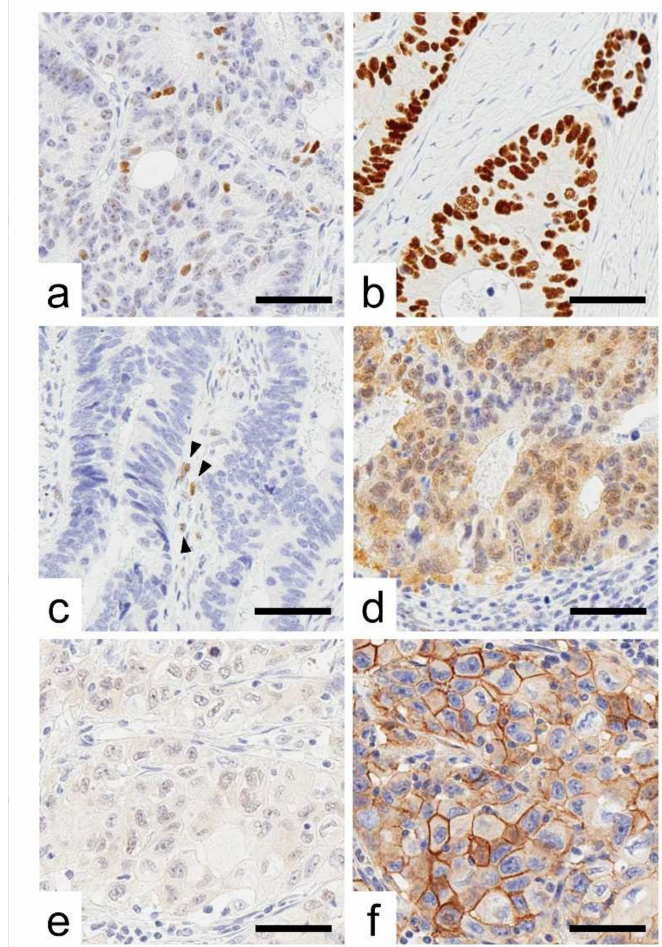
Figure 1. Representative images of p53 immunoreactivity. ( a – d ), Representative images of p53 immunoreactivity. ( a ) Wild-type pattern, ( b ) overexpression, ( c ) cytoplasmic expression, and ( d ) complete loss. Arrow heads indicate internal control cells with weak p53 nuclear expression. ( e , f ), CRC cases with the “stem-like” immunophenotype showing CDX2-negative ( e ) and ALCAM- positive expression ( f ). Bar, 50 µ